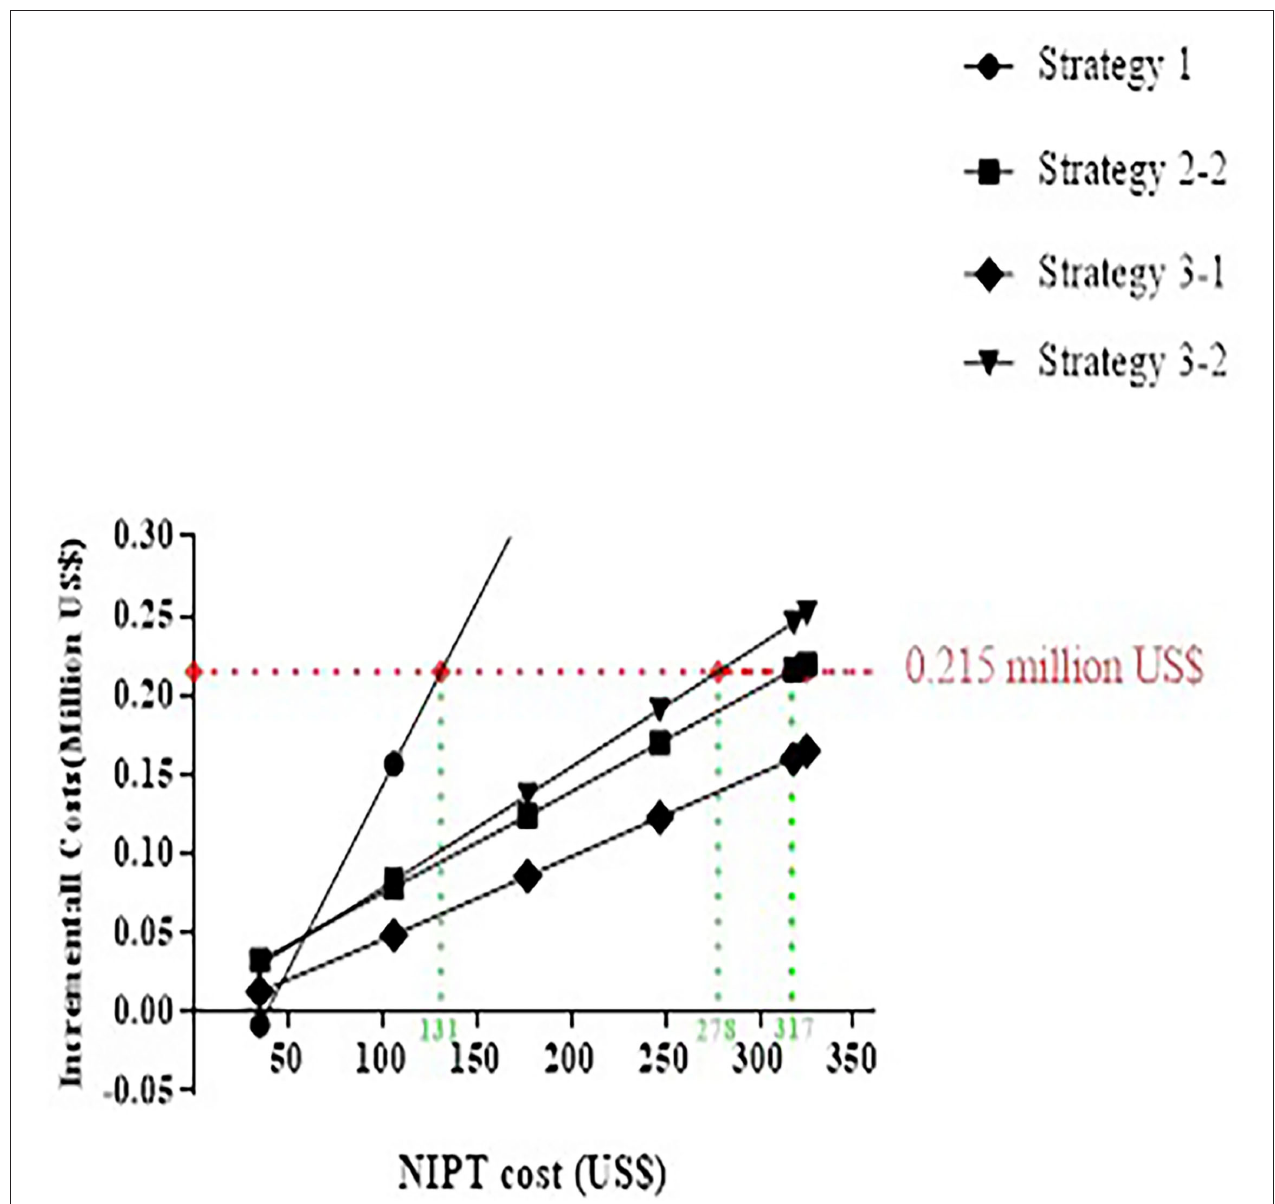
FIGURE 5 | The incremental cost analysis for NIPT price-setting Strategy 2-1 as a baseline.